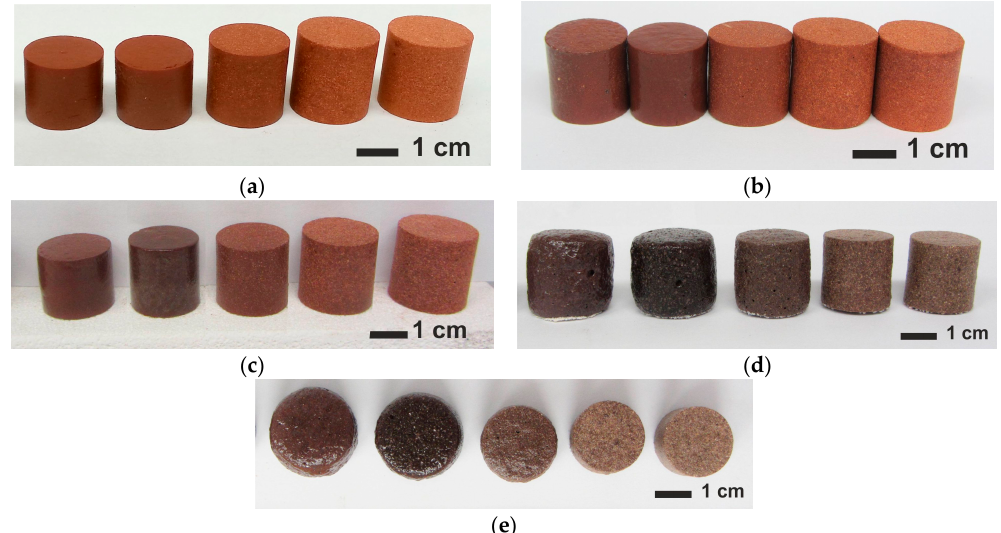
Figure 1. Appearance of samples with CS load (from left to right in each row) 0, 10, 30, 50 and 60 vol % of CS, ( a ) fired at 1000 °C, ( b ) 1050 °C, ( c ) 1100 °C, ( d , e ) 1200 °C—( d ) side view and ( e ) top view.